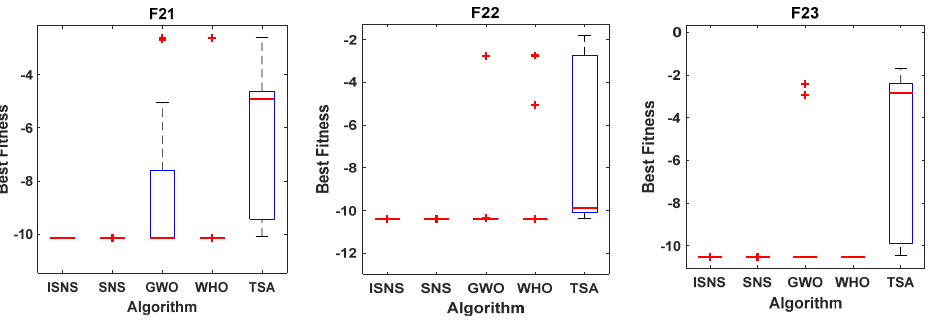
Figure 12. Boxplots for all algorithms for 23 benchmark functions.